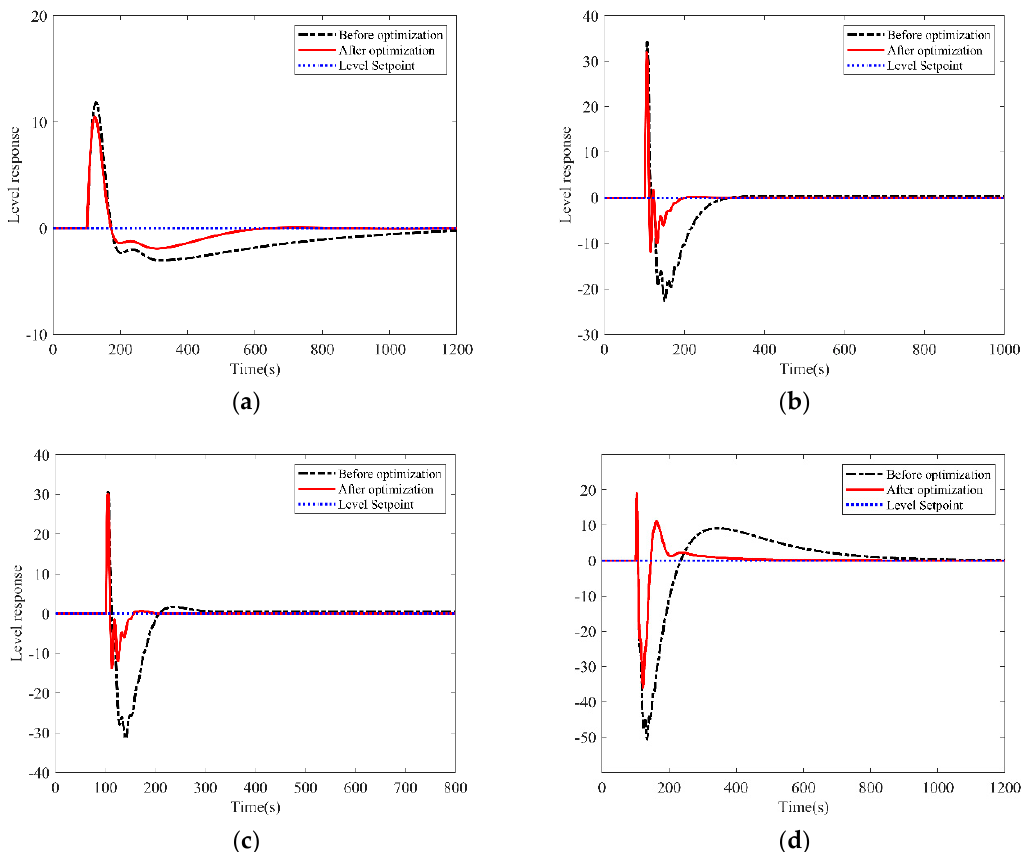
Figure 15. Curve of water level change before and after optimization: ( a ) 5% FP; ( b ) 30% FP; ( c ) 50% FP; ( d ) 100% FP.